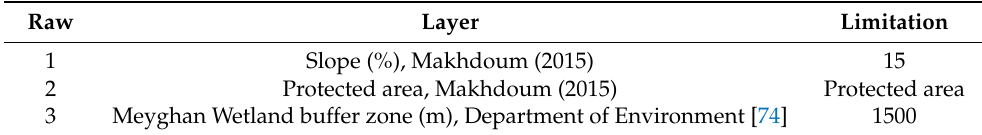
Table 3. Imposed limitation of land use for